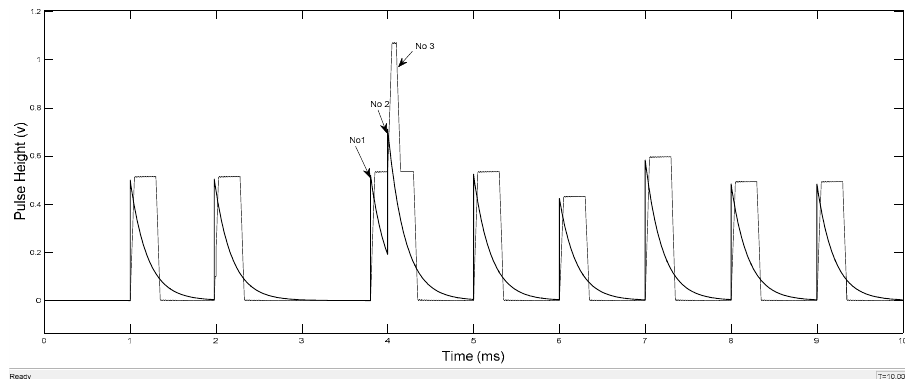
Figure 11. Pile-up 2 using the TPS algorithm.